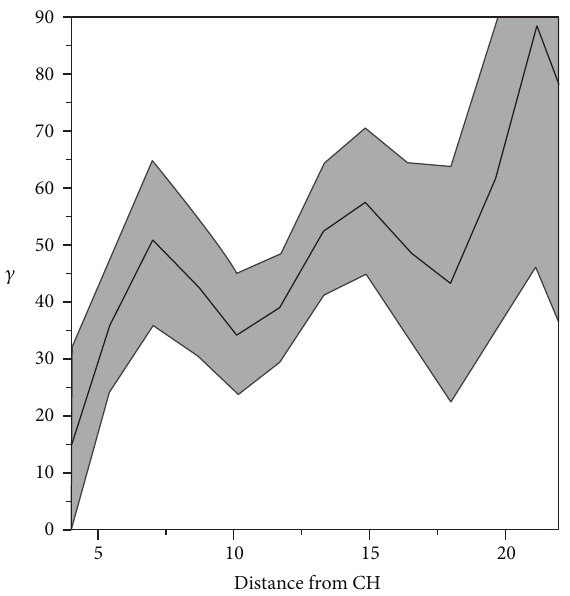
Figure9:Angle 𝛾 asafunctionofdistancefromtheCHphotometric boundary. The grey area shows the 95% confidence